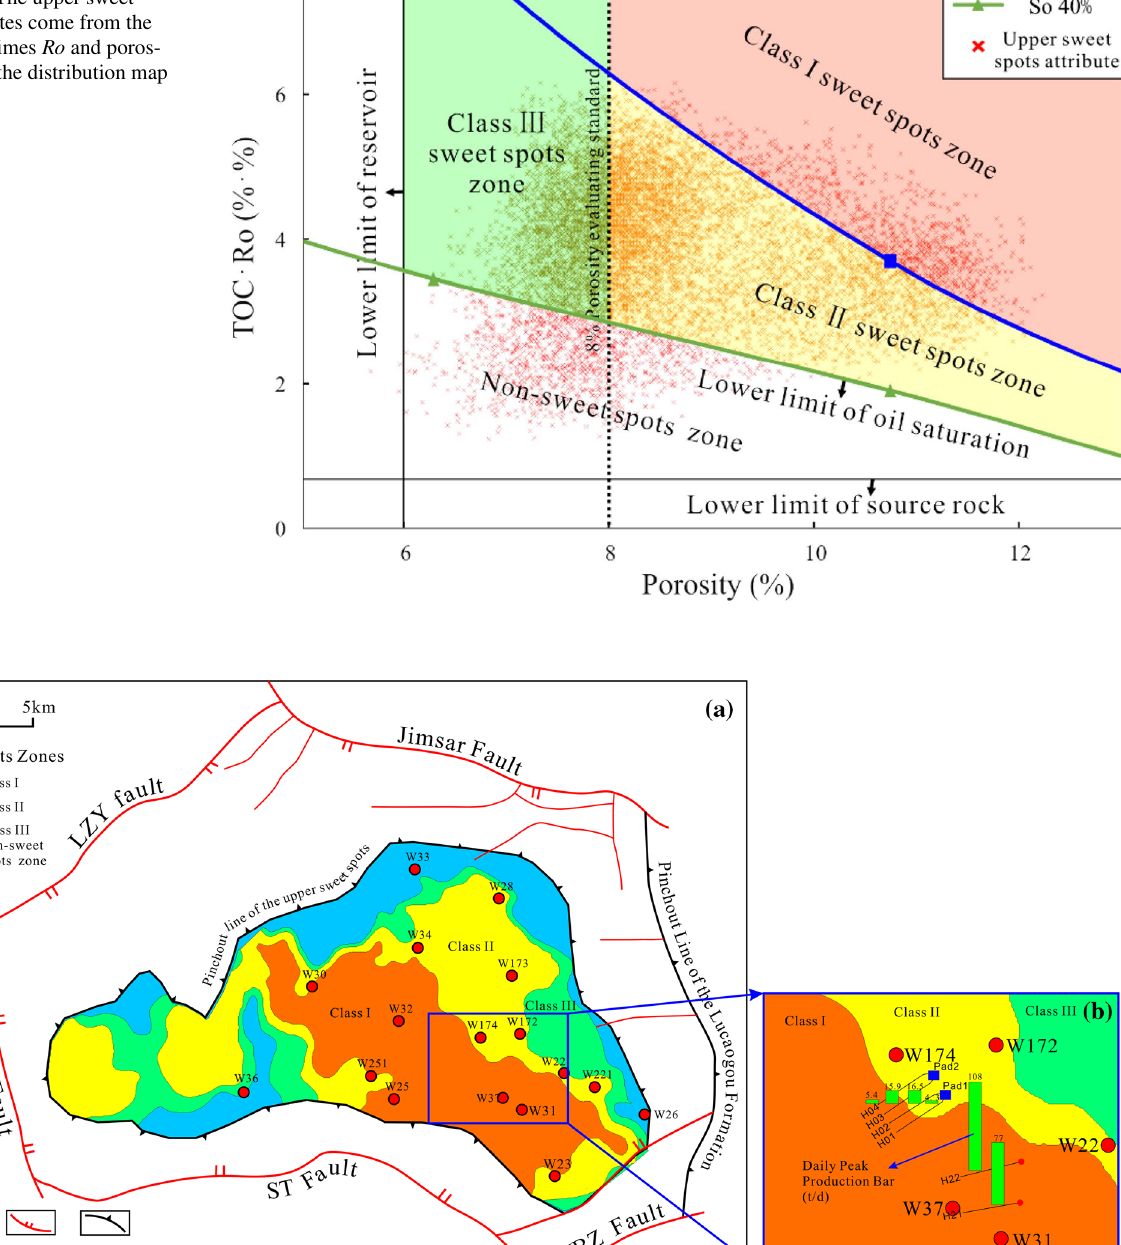
Fig. 8 Sweet spots evaluation chart of the Jimsar’s Lucaogou Formation. The upper sweet spots attributes come from the grids TOC times Ro and poros- ity value of the distribution map